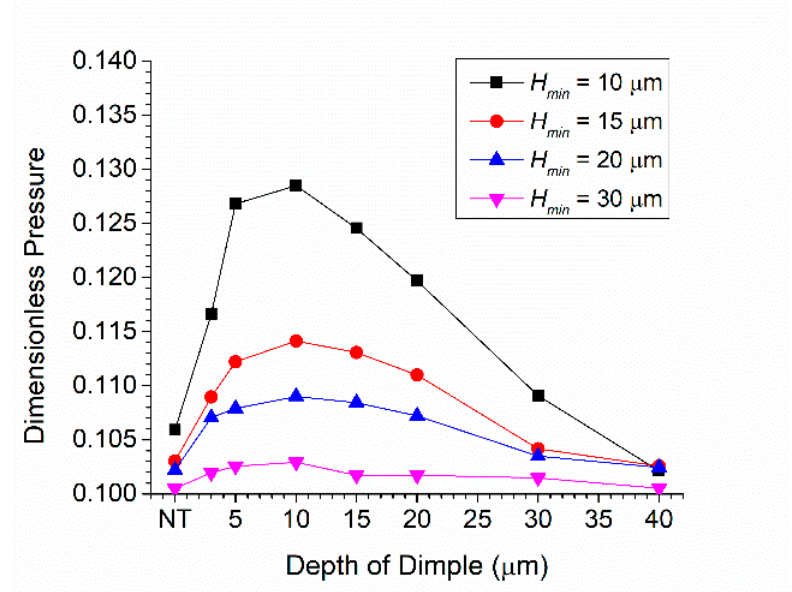
Figure 9. Comparison of average pressure on the top surface of the model for varying dimple depths (NT indicates the non-textured case).